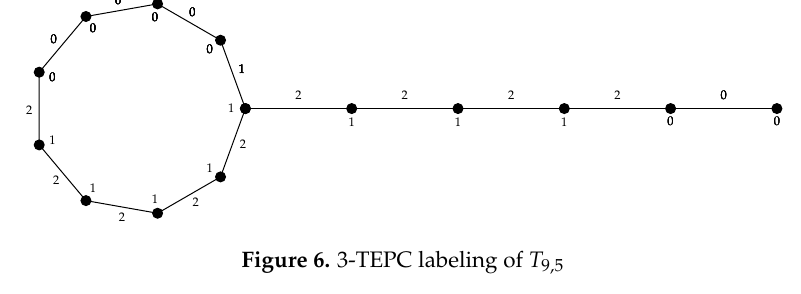
Figure 6. 3-TEPC labeling of T